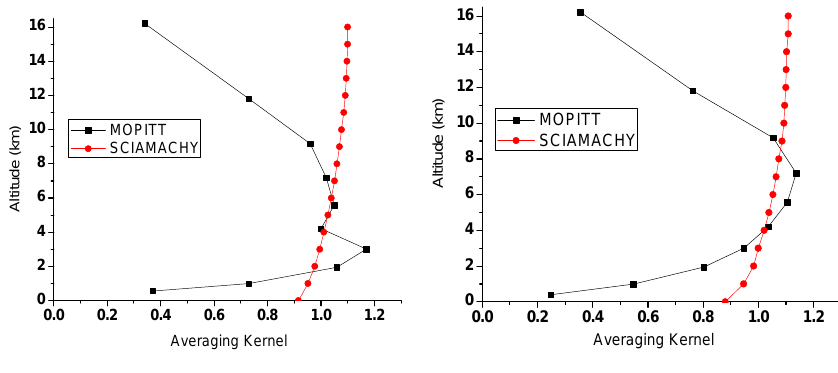
Fig 5. Examples of MOPITT’s and SCIAMACHY’s monthly mean averaging kernels over Fig. 5. Examples of MOPITT’s and SCIAMACHY’s monthly mean averaging kernels over central Africa (left, 5 ◦ N to 12 ◦ N; 15 ◦ W to central Africa (left, 5°N to 12°N; 15°W to 32°E, January 2004) and East of China (right, 20°N to 32 ◦ E, January 2004) and East China (right, 20 ◦ N to 40 ◦ N; 107 ◦ E to 123 ◦ E, May 2004). Only observations with effective cloud fraction 40°N; 107°E to 123°E, May 2004). Only observations with effective cloud fraction <20% are < 20% are selected. selected.